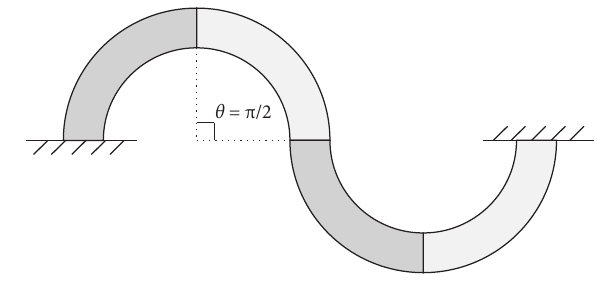
Figure 11: A composite curved beam